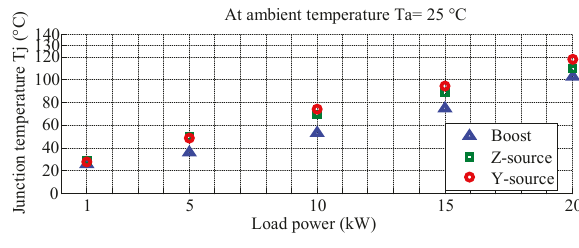
Fig. 6. Junction temperature variation of the switch at different power loading and using a voltage gain of 2.